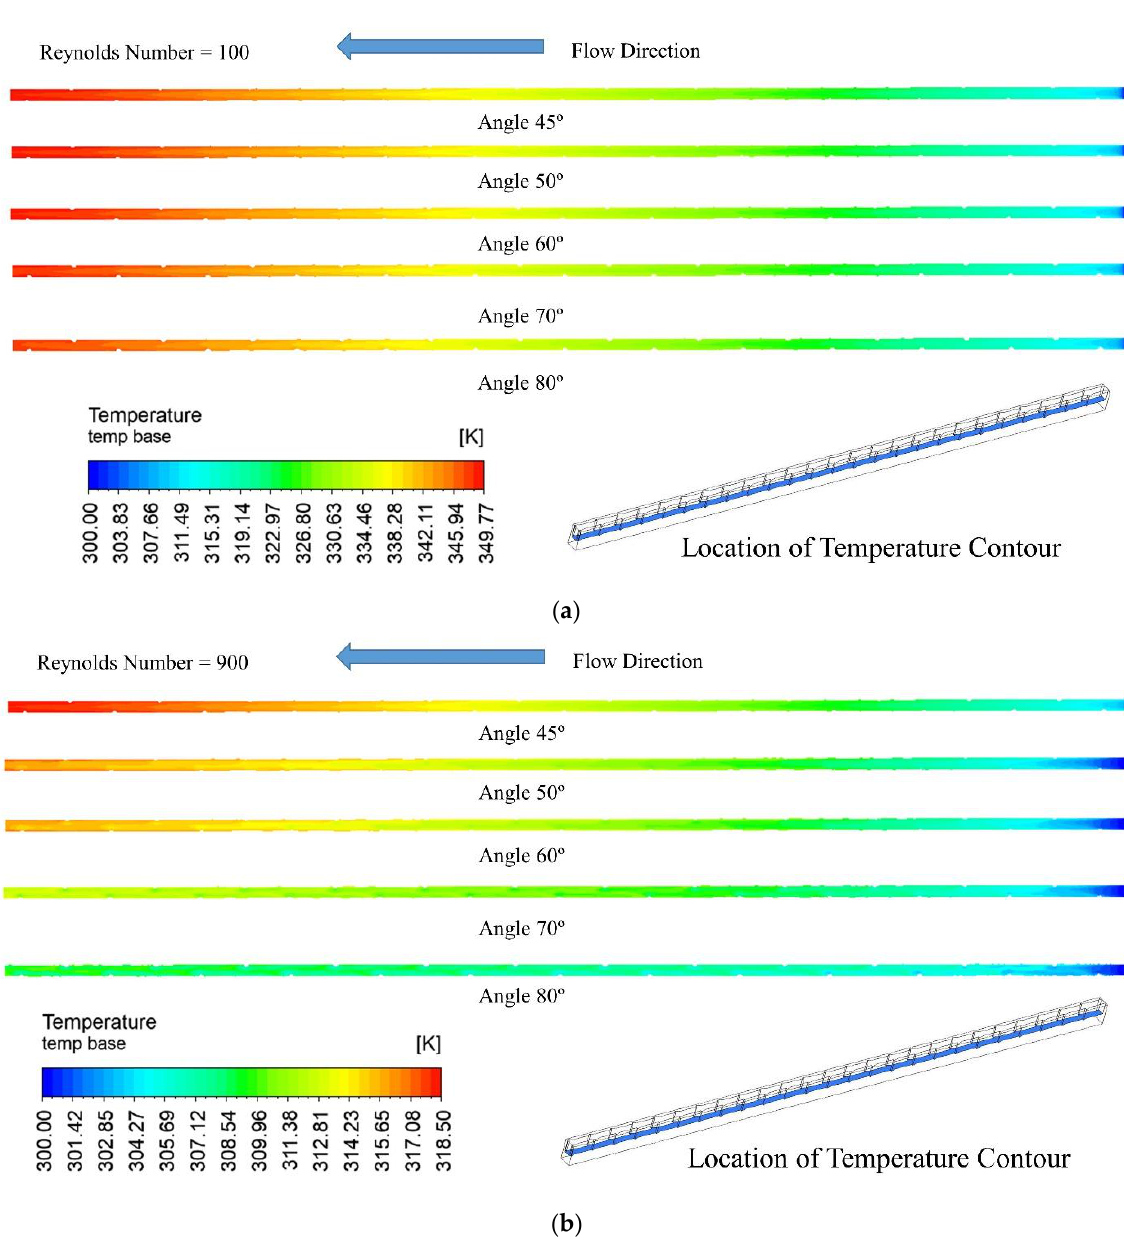
Figure 7. Temperature profile at the mid plane of the microchannel and fluid domain at ( a ) Re = 100 and ( b ) Re = 900.